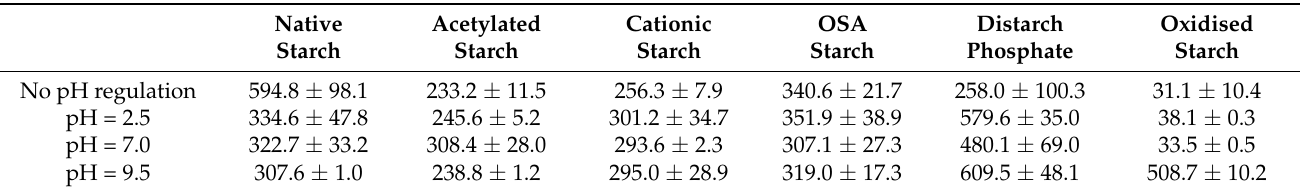
Table 6. Intensity weighted mean hydrodynamic diameter (z-average) recorded in the analysed starch samples [nm].